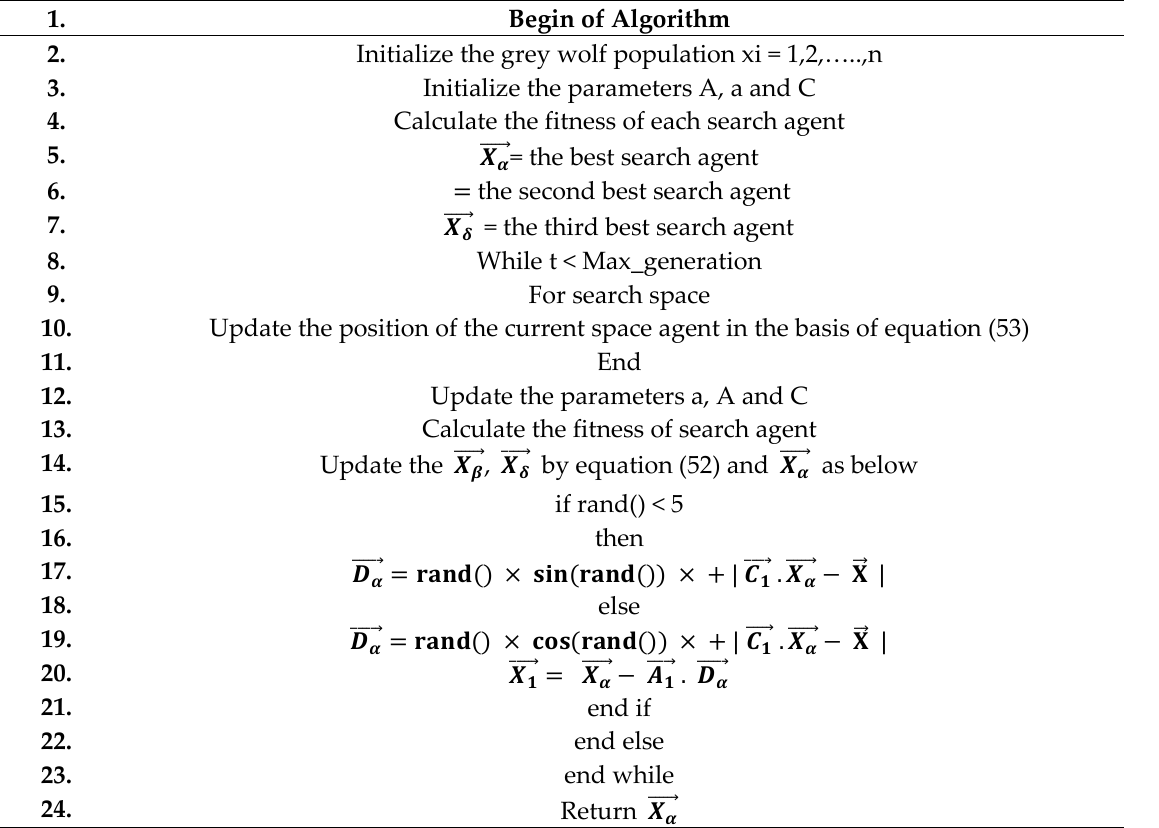
Table 7. Optimal design variables using semi-hourly measurement data.